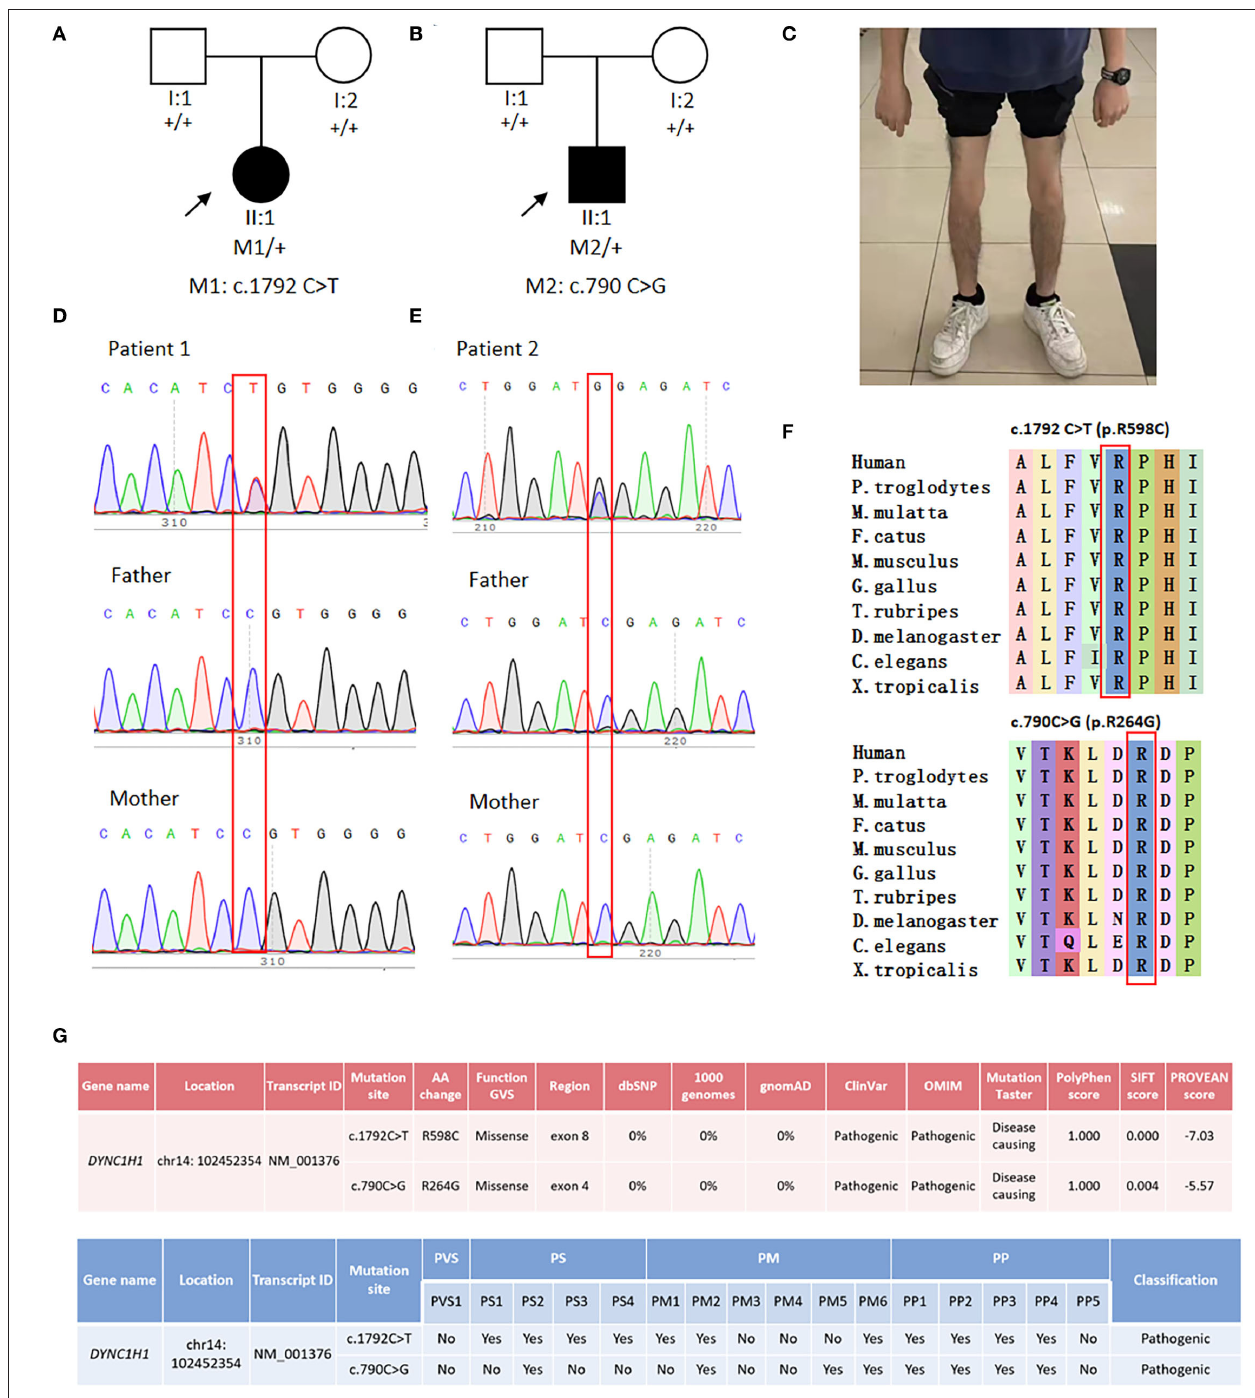
FIGURE 1 | Genetic analysis and clinical phenotypes of two SMALED1 pedigrees. (A) Family tree of patient 1. (B) Family tree of patient 2. (C) Patient 2 presented with obvious muscle wasting in both distal lower limbs. (D) Sanger sequencing of Patient 1 and her parents revealed a de novo DYNC1H1 gene mutation c.1792C > T. (E) Sanger sequencing of patient 2 and his parents revealed a de novo DYNC1H1 gene mutation c.790C > G; the affected member is marked in black, and the proband is indicated by arrows. (F) Affected amino acids R598 and R264 were conserved in human and various other vertebrates. (G) Pathogenicity prediction of the mutations by several in silico bioinformatic tools and according to ACMG guidelines.